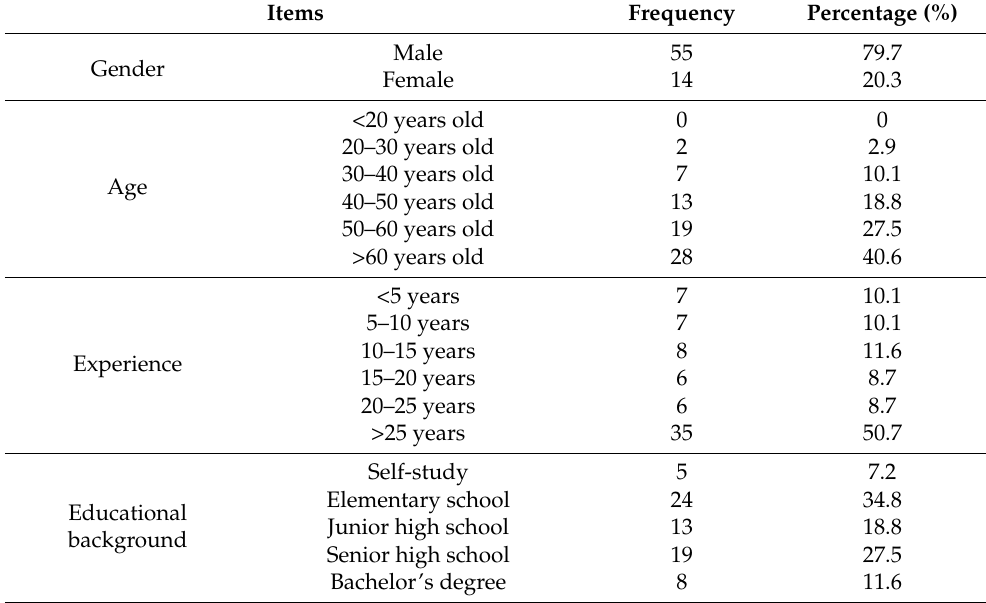
Table 1. Demographic information of the respondents ( n =